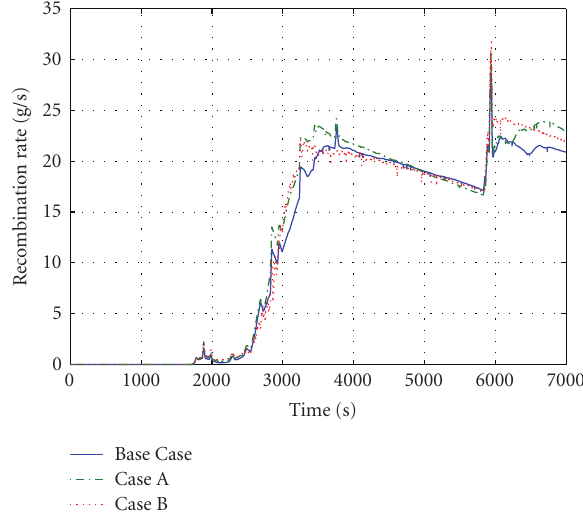
Figure 11: Total recombination rate of 22 PARs.